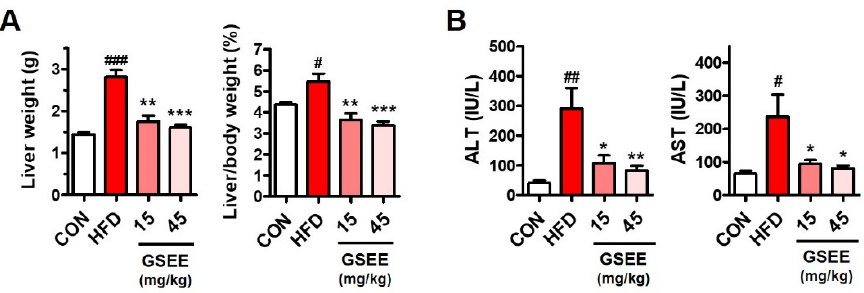
Figure 4. Effects of GSEE on liver weight and serum hepatotoxicity indicators in HFD-fed obese mice: ( A ) liver weight and the ratio between liver and body weight (%); ( B ) serum alanine transaminase (ALT) and aspartate transaminase (AST) activities. Mice ( n = 8 in each group) were fed with HFD for 10 weeks with or without daily oral administration of GSEE (15 or 45 mg/kg of body weight). Values are represented as mean ± SE. Student’s t -Test, #, ##, ### p < 0.05, 0.01, and 0.001, respectively, vs. control. *, **, *** p < 0.05, 0.01, and 0.001, respectively, vs. HFD.